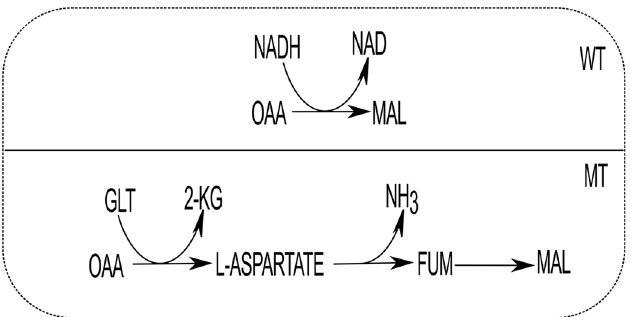
Fig 3. Adaptation of alternate metabolic route due to deletion effect. An example of OAA to MAL synthesis is shown. WT is the path preferred by the cellular metabolism in wild type condition to produce malate in cytosol. Mutant type (MT) shows the alternative route of the WT. Here, GLT indicates